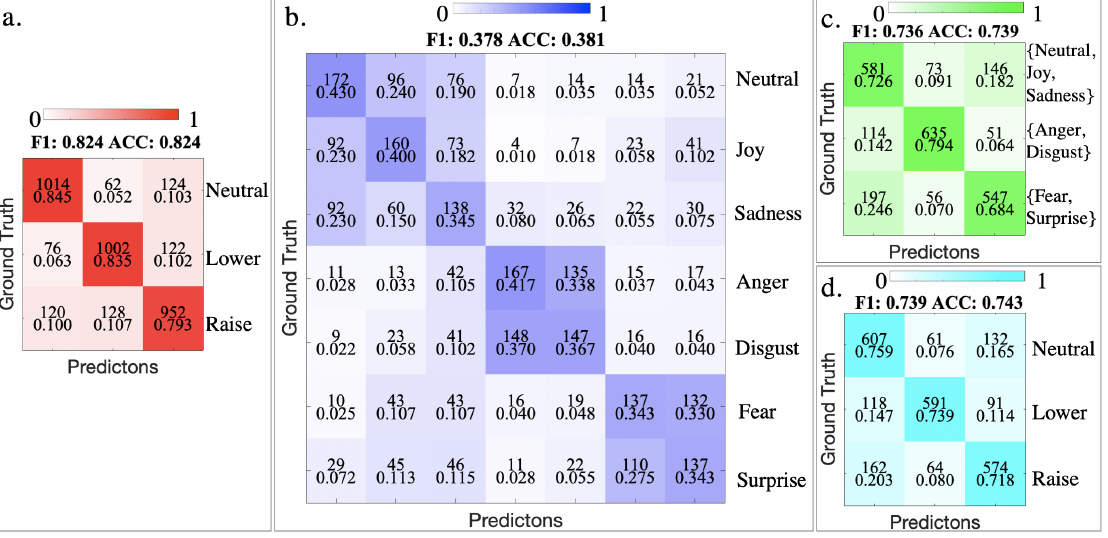
Figure 6. Confusion Matrix of Mode 1 ( a ), Mode 2 ( b ) and Mode 3 ( c ). ( d ) is the confusion matrix of a Support Vector Machine (SVM) classifier trained with data from Mode 1, tested on the data from Mode 3. The upper number in each cell is the sample count, the lower number is precision and false negative